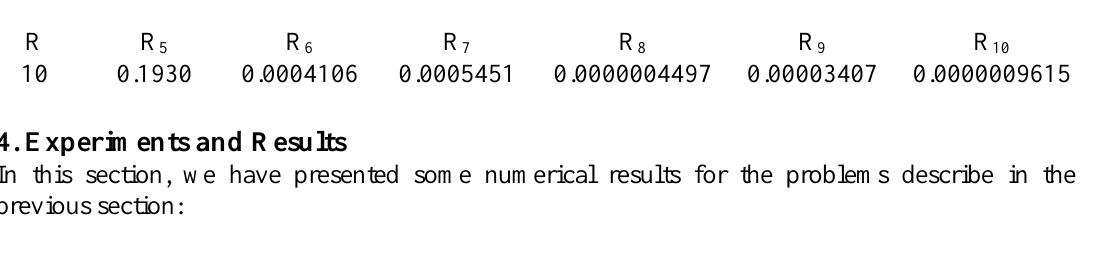
Table 1. Parameters used by GWO algorithm for various